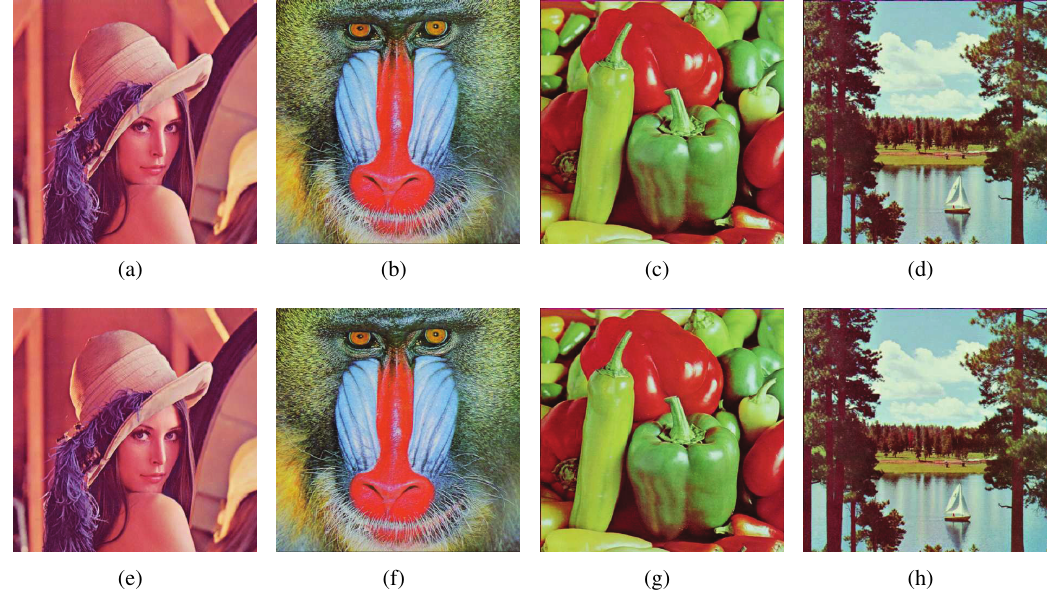
Figure 10: RGB watermarked images embedded by (a)-(d) RTU logo and (e)-(h) Aeroplane